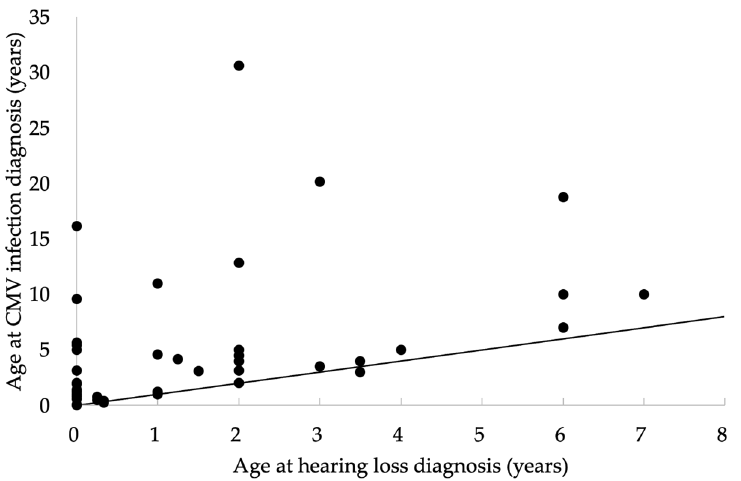
Figure 1. Relationship between age at hearing loss diagnosis and age at cytomegalovirus (CMV) infection diagnosis. The line indicates equal ages at hearing loss diagnosis and CMV infection diagnosis.